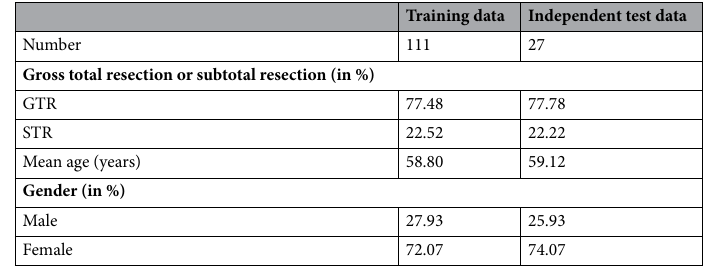
Table 1. Clinical and demographic